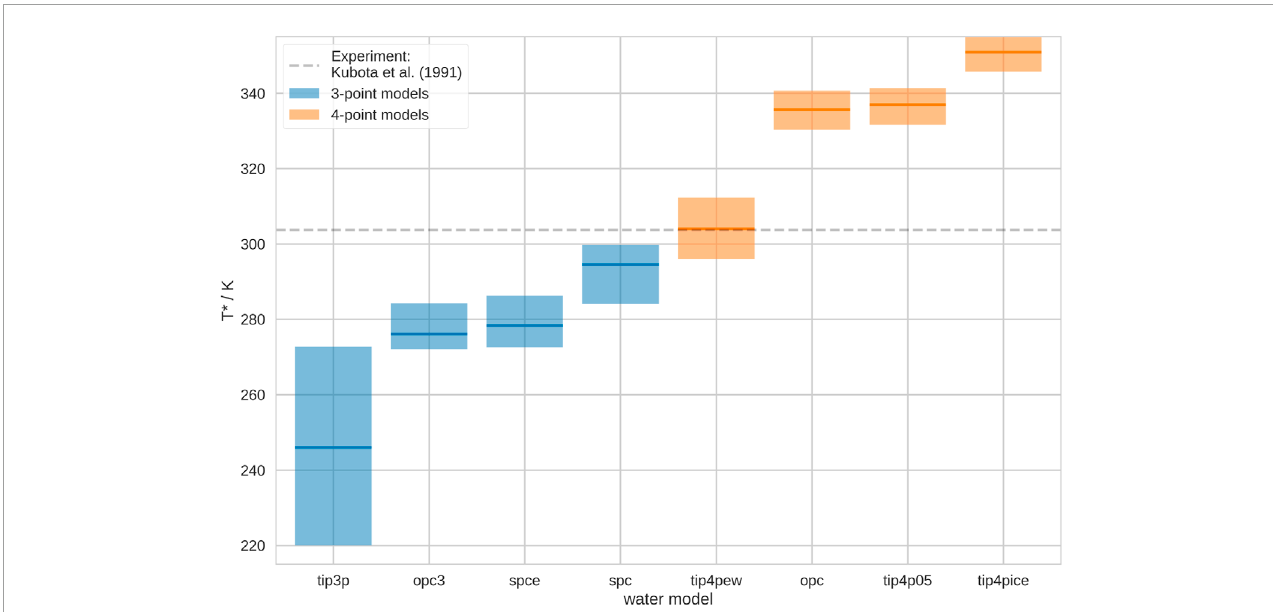
FIGURE 1 Coil-Globule transition temperature, T *, in different water models. We show the mean transition temperature with a min./max. uncertainty estimate from leave-one-out cross-validation. The water models are ordered according to mean T *. 3-point water models are shown in blue, 4-point water models are shown in orange. These results correspond to infinite dilution. As grey dashed line, we show the experimental transition temperature T * = 303.74 ± 0.05 K, as reported by Kubota et al.